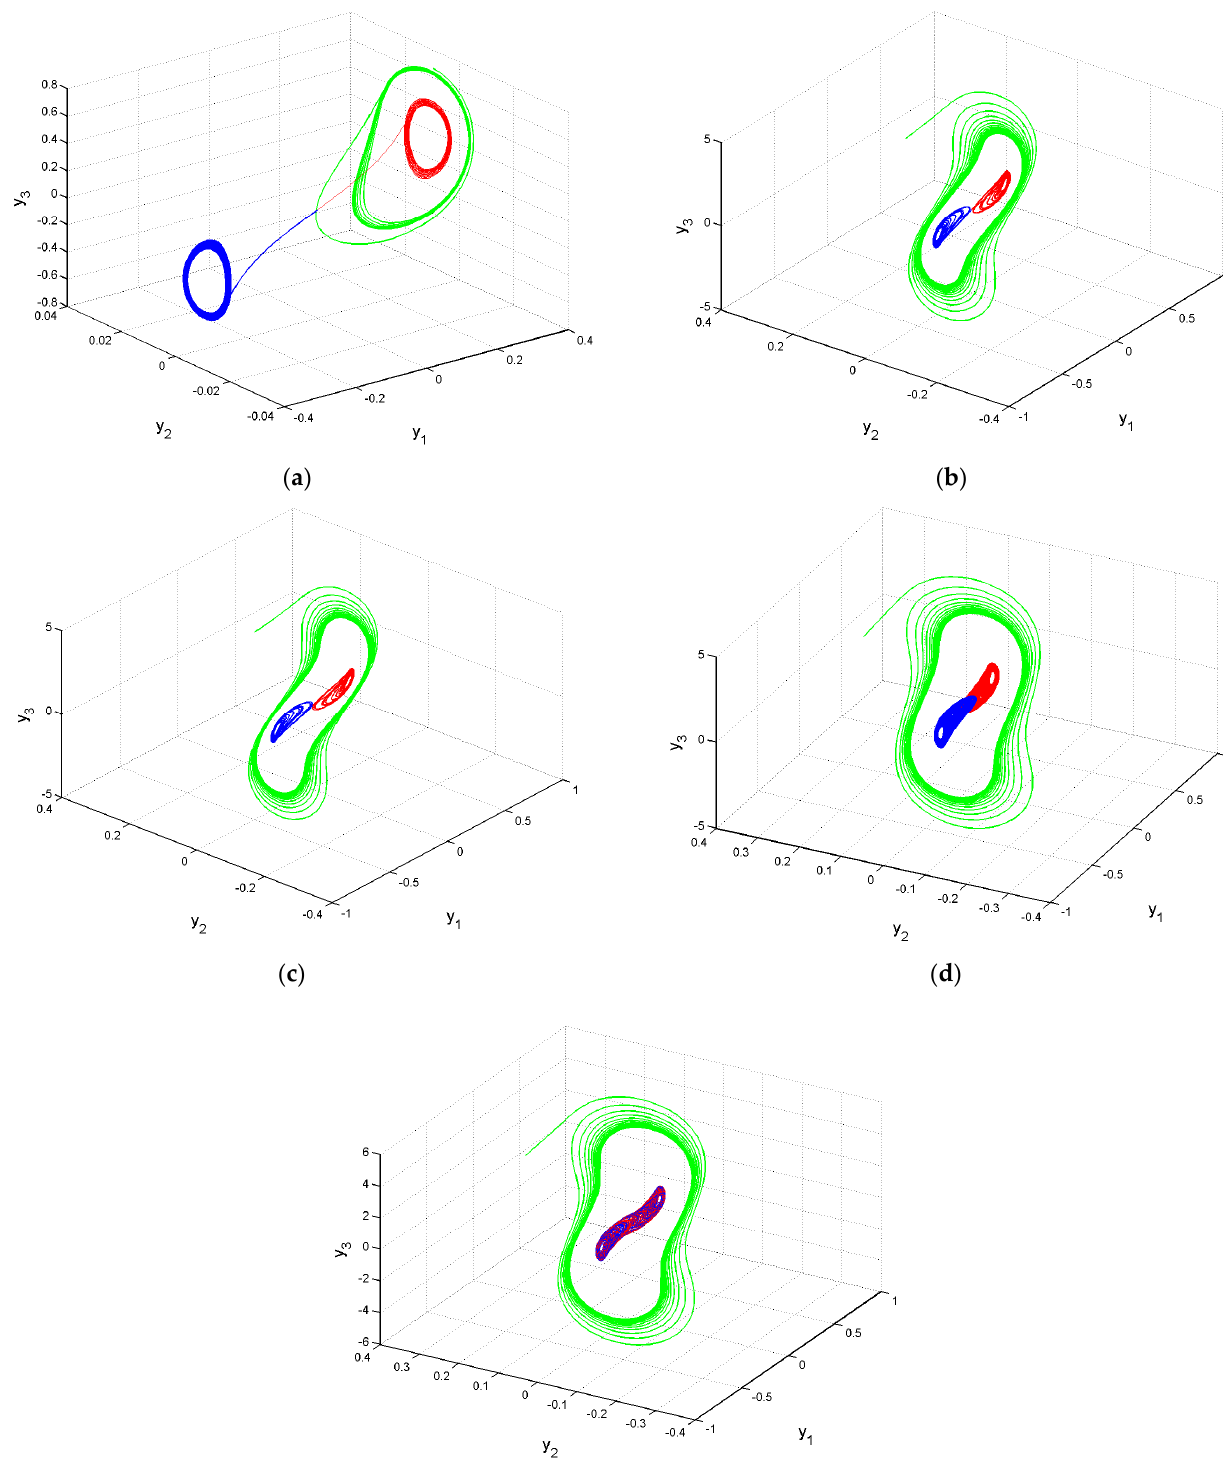
Figure 4. The phase graphs of the system (3) using γ = 0.1, δ = 100, ρ = 200 and: ( a ) ξ = 3.5, ( b ) ξ = 3.1, ( c ) ξ = 3.05, ( d ) ξ = 2.85 and (e) ξ =